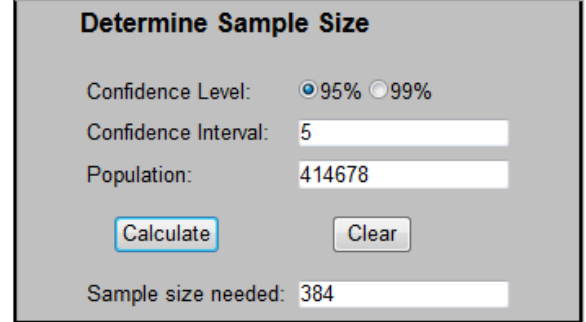
Figure 2. Sample size calculator.